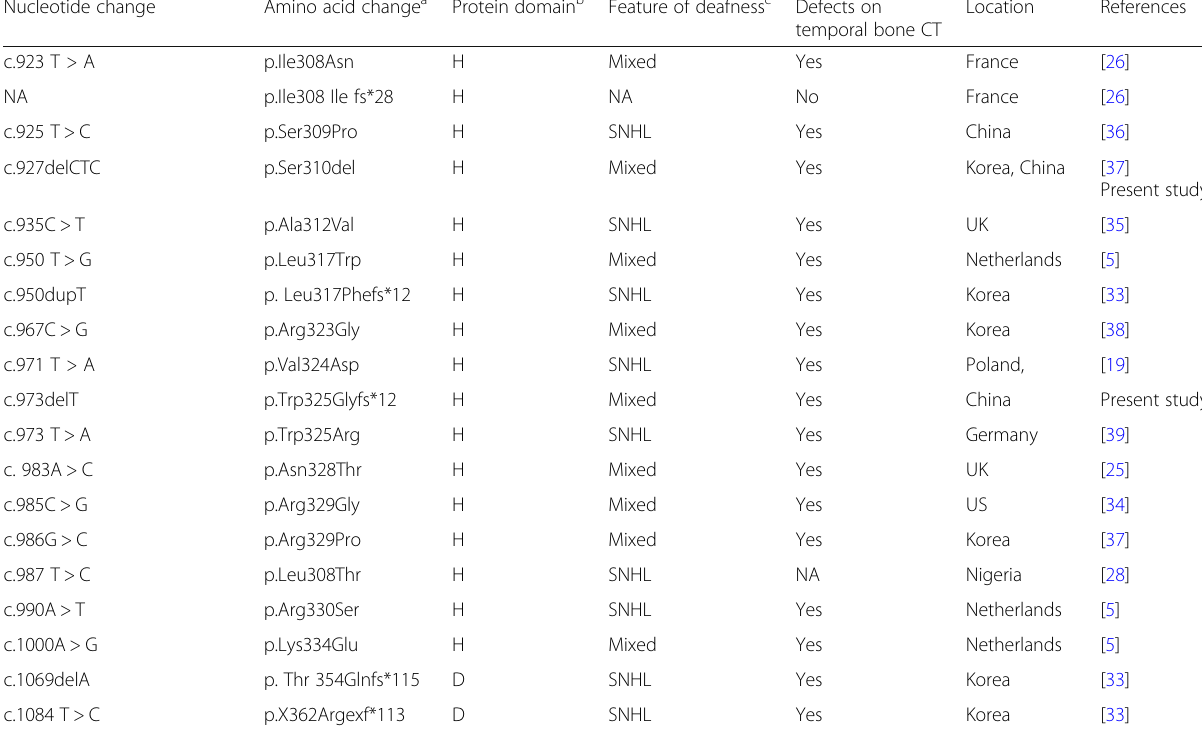
Table 1 Reported Mutations in the POU3F4 Gene Resulting in DFNX2 Phenotypes (Continued) Nucleotide